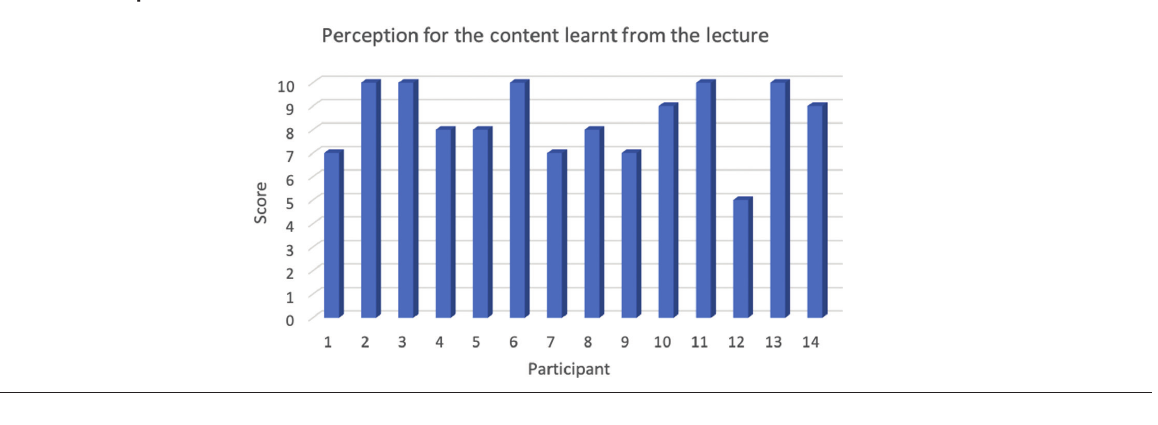
Figure 20. Perception of the content learnt from the lecture (Source: Author, 2022)